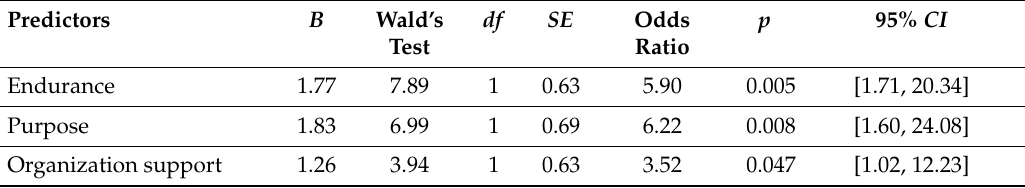
Table 5. Results of the binary logistic regression to predict subjective